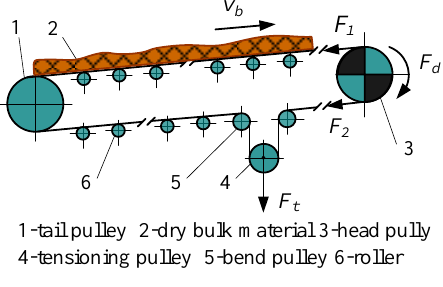
Figure 5. Belt conveyor model.